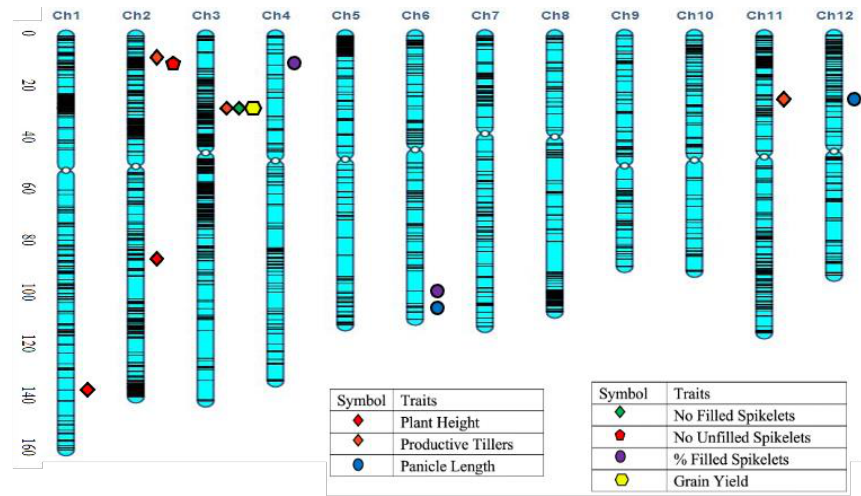
Figure 4. Genetic linkage map using 6209 SNP markers based on the BC 1 F 2 mapping population of Hasawi × BRRI dhan28 showing QTLs mapped under salinity stress of EC 10 dS/m at the reproductive stage of rice. Significant QTLs are shown at the right side of each chromosome (Ch) based on the genetic position in centimorgan (cM) of the SNP markers. Table 1. QTLs identified in a Hasawi × BRRI dhan28 population using Inclusive Composite Interval Mapping (ICIMapping) with a LOD 3.0 threshold for salt stress at the reproductive stage of